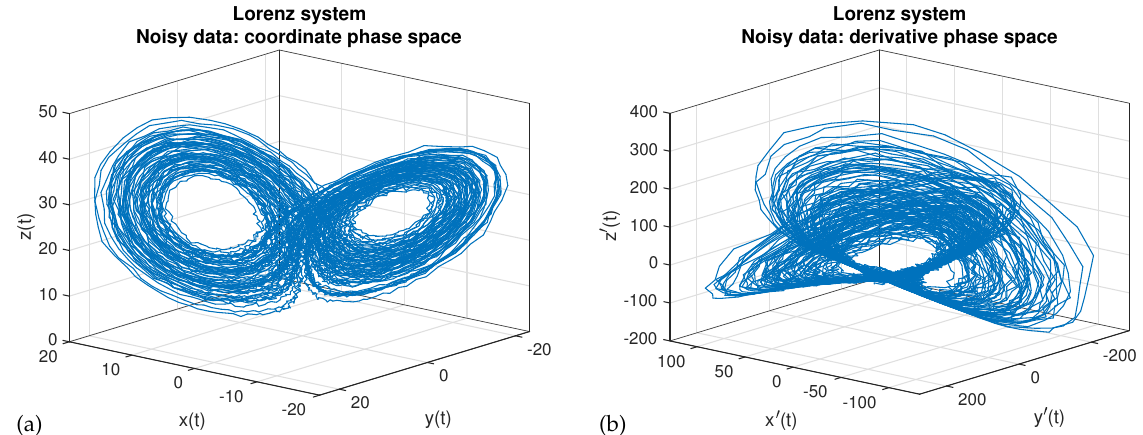
Figure 1. Calculated noisy data for the Lorenz system: ( a ) parameters X , and ( b ) derivatives ˙ X